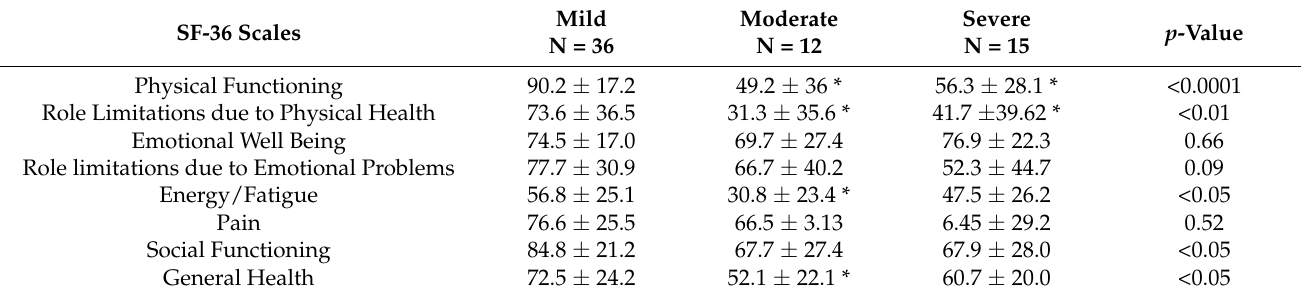
Table 3. SF-36 scores according to COVID-19 disease severity.